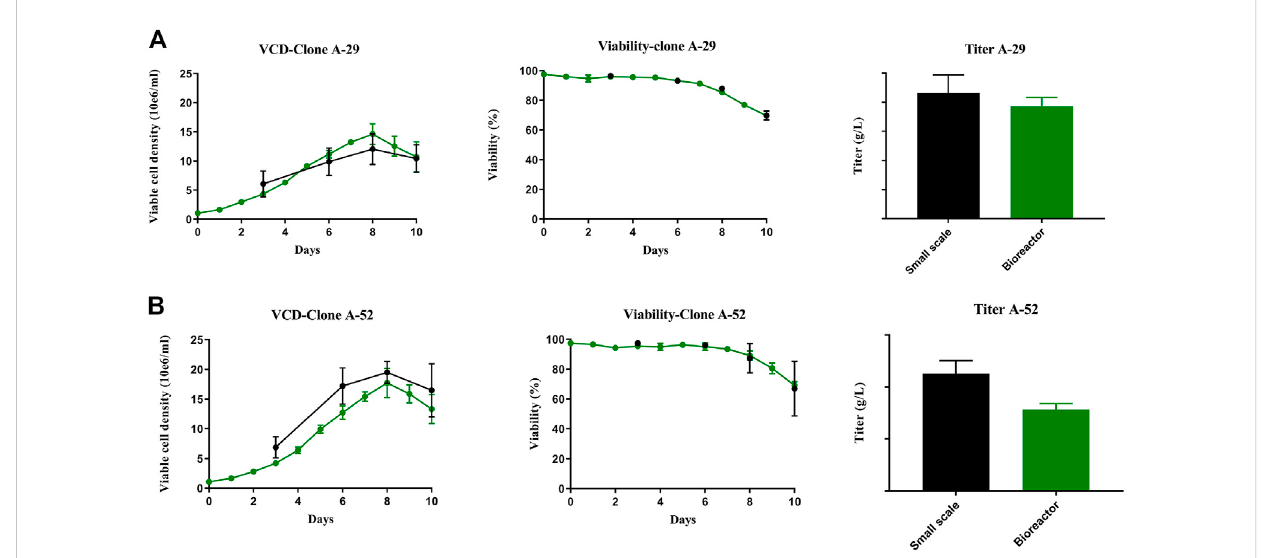
FIGURE 8 Comparison of process performance across scales. Clone A-29 and A-52 were compared in 10 days fed-batch productions small scale (spin tubes) and benchtop Applikon bioreactors. (A, B) VCD, Viability and titer plots for A-29 and A-52 respectively. Error bars represent the standard deviation calculatedfromdataobtainedinthreeindependentexperiments( n =4)forsmallscalespintubeandbiologicalreplicates( n =3)inbioreactorproduction.